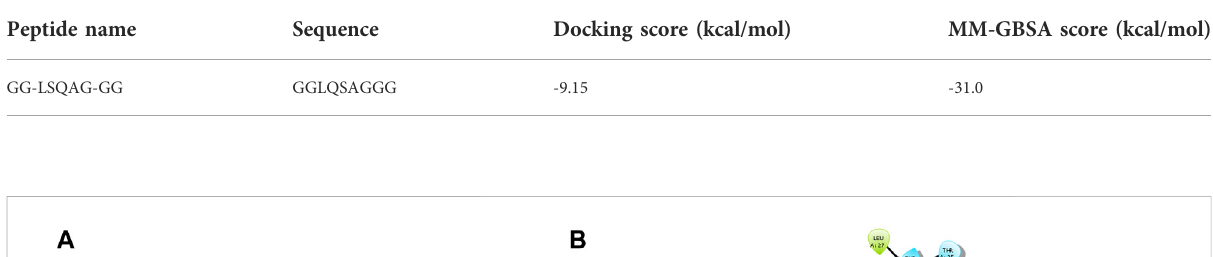
TABLE 2 Peptide Docking scores with the SARS-CoV-2 Main Protease.